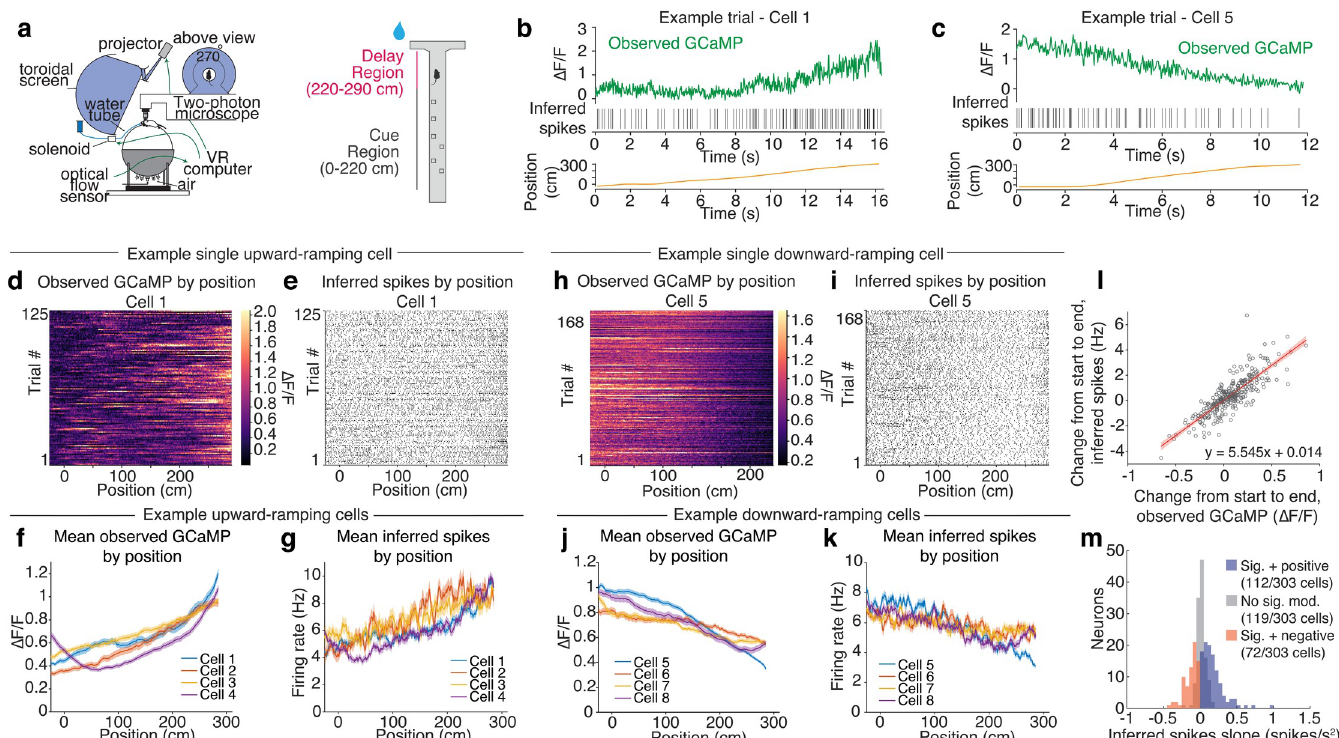
Fig 4. Upward and downward ramps in inferred spikes during reward approach in a virtual reality environment, in agreement with recent reports from electrophysiology. a. Left: Schematic of neural recording and behavioral setup. The mouse navigates a virtual reality (VR) environment and 2p microscope records neural data. Right: Schematic of VR T-maze paradigm. The mouse navigates a linear maze and at the end must turn to the side that featured more cues in the Cue Region to receive reward. b. Example of single trial data from an upward-ramping cell. Both observed GCaMP (green) and inferred spikes ramp upward over time as the mouse moves down the maze (position trace, yellow). c. Example of a single trial from a downward-ramping cell. Both observed GCaMP (green) and inferred spikes ramp downward over time as the mouse moves down the maze (position trace, yellow). d. All trials from the example upward-ramping cell in (b) of observed GCaMP by position. e. All trials from the example upward-ramping cell in (b) showing inferred spikes by position. f. Mean observed GCaMP by position for example upward- ramping cells. g. Mean inferred firing rate by position for example upward-ramping cells. h. All trials from the example downward-ramping cell in (c) of observed GCaMP by position. Heatmap color scales constrained to data between 1st and 99th percentile. i. All trials from the example downward-ramping cell in (c) showing inferred spikes by position. j. Mean observed GCaMP by position for example downward-ramping cells. k. Mean inferred firing rate by position for example downward- ramping cells. Shaded areas are SEM. l. Scatterplot showing how change in observed GCaMP from beginning to end of maze for each neuron relates to change in inferred firing rate for that neuron. Each data point represents a single neuron and its mean change in observed GCaMP and inferred firing rate. Red line is linear least- squares fit; shaded region is 95% confidence of the fit. m. Distribution of inferred spike slopes over time among neurons with significant position modulation with negative (red; mean slope = -0.12 spikes/s 2 ; n = 72/303 neurons) or positive (blue; mean slope = 0.18 spikes/s 2 ; n = 112/303 neurons) ramps, or with no significant position modulation (grey; mean slope = 0.02 spikes/s 2 ; n = 119/303 neurons). Significant position modulation determined by a generalized linear model (GLM), where the inferred spikes were predicted by mouse position, with a factor for individual trials, where neurons were classified as significantly ramping if the coefficient associated with position was statistically significant at level alpha = 0.01. Data is from a mix of cells expressing either GCaMP6f or GCaMP6m.